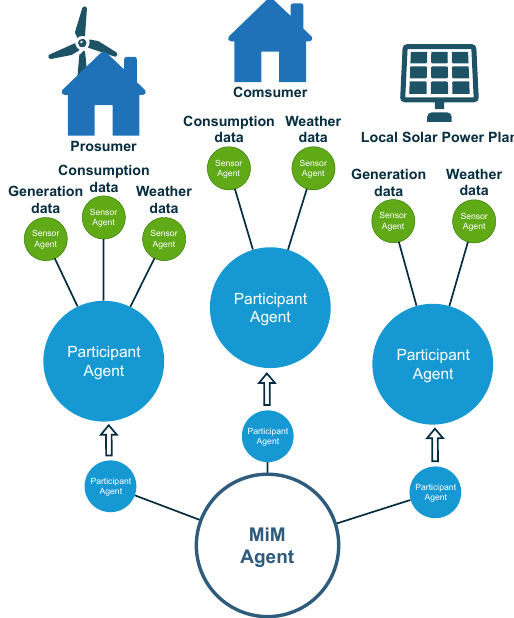
Figure 1. Proposed LEM model diagram